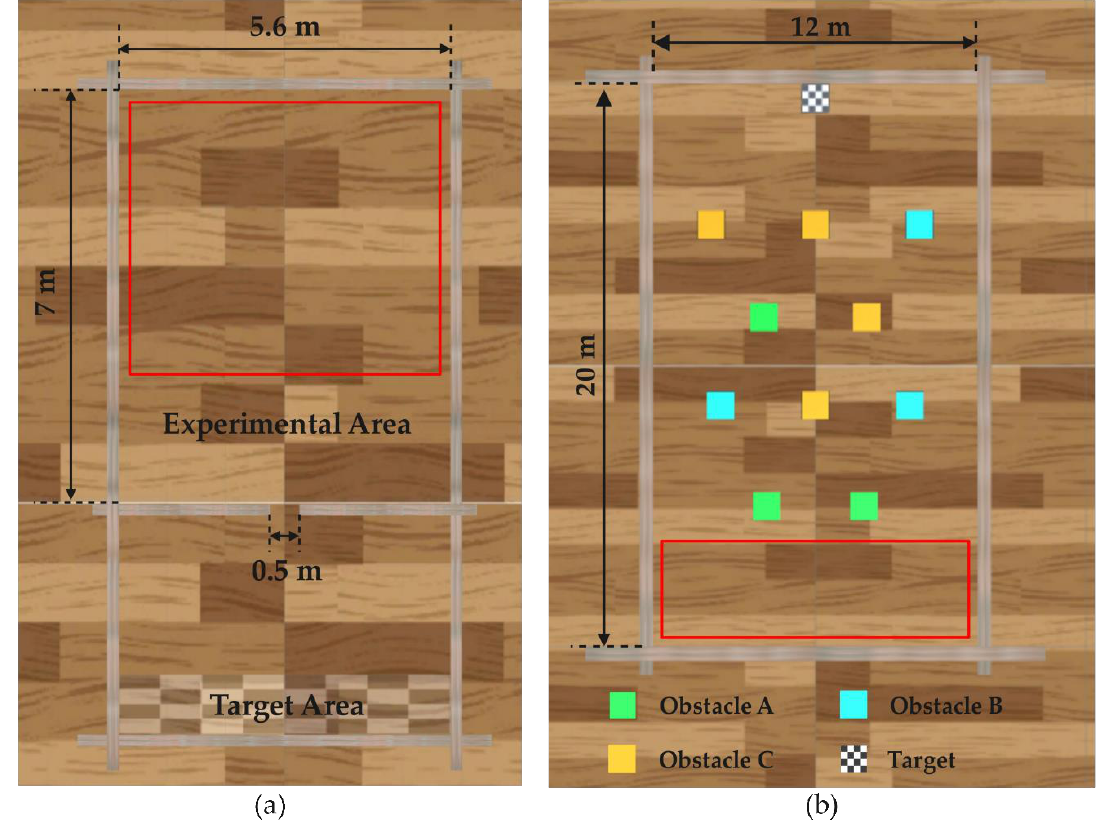
Figure 5. Experimental scenarios. ( a ) Scenario I; ( b ) scenario II.